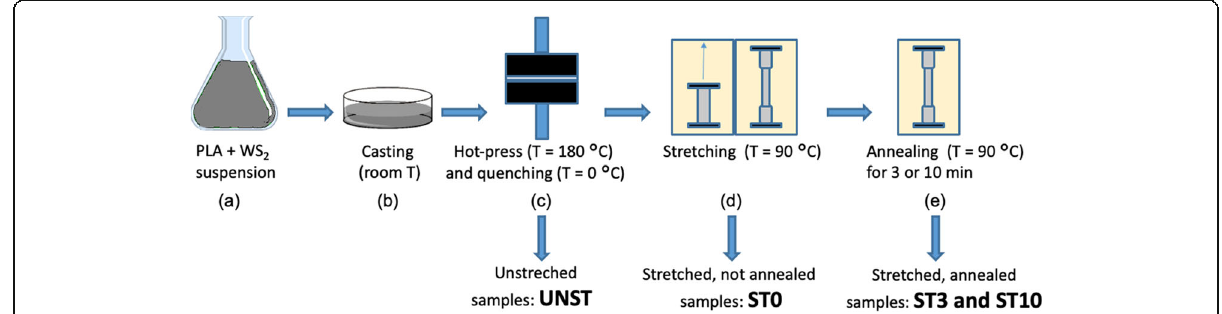
Fig. 1 Scheme of the preparation process of PLA and PLA-WS 2 films and corresponding acronyms used in the